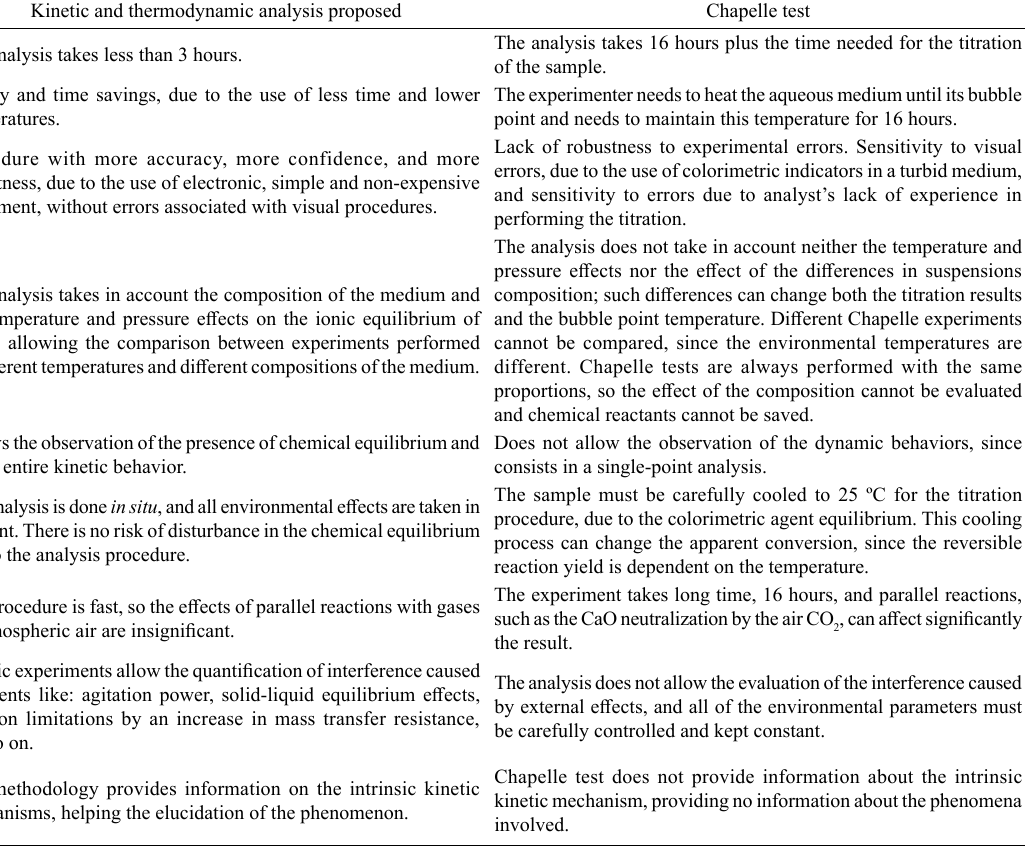
Table 6. Comparison between the proposed methodology and the Chapelle test 4-6 . Kinetic and thermodynamic analysis proposed